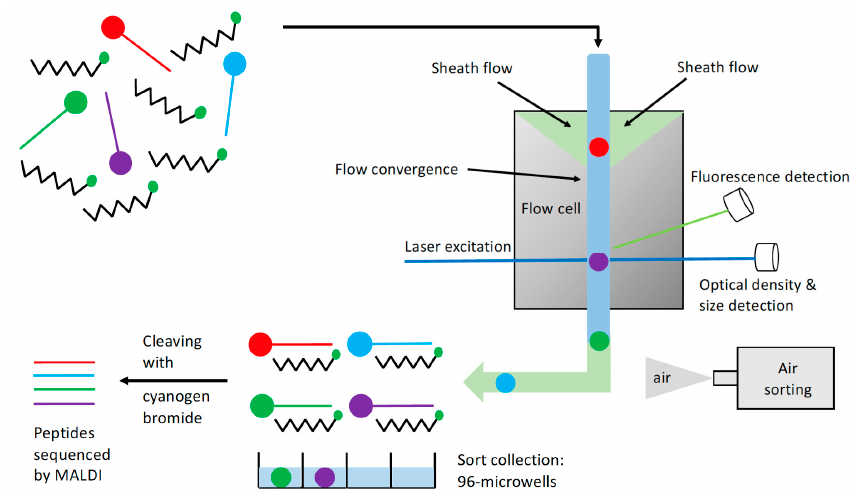
Scheme 2. Illustration of the bead screening process for a complementary peptide that can